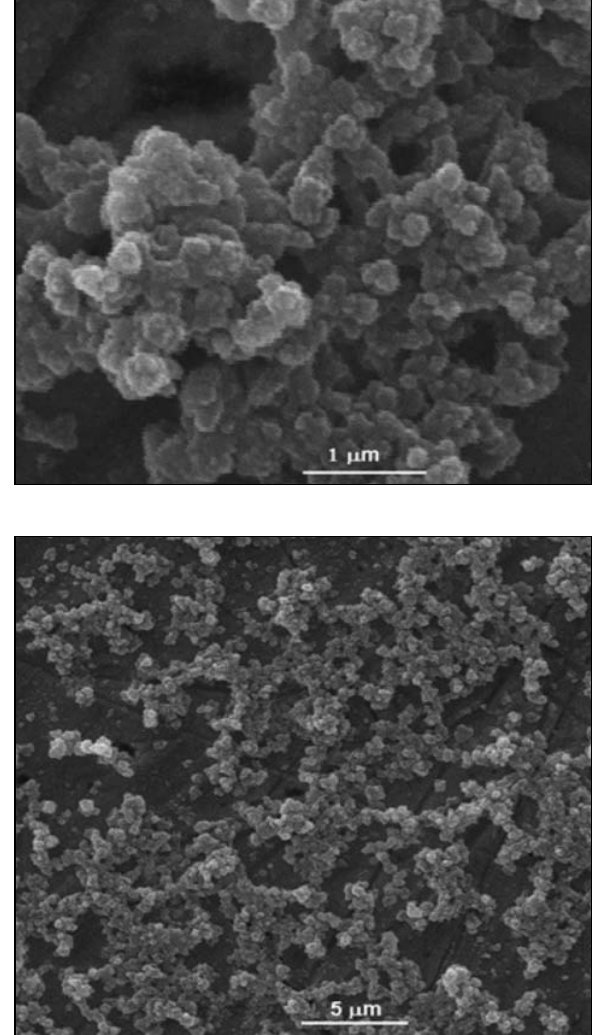
Fig. 4. SEM images for PAAQ-SDS film (in different magnifica-